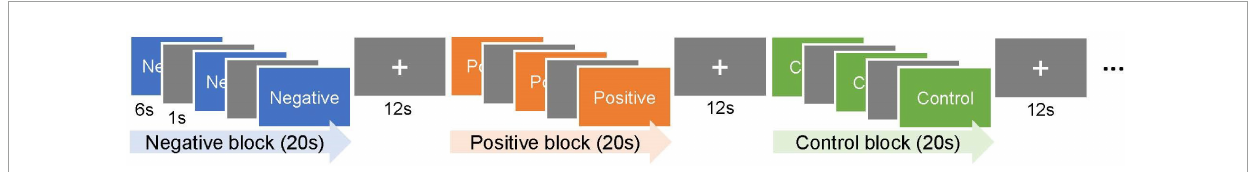
FIGURE1 Experimental design. Each block consisted of a serial presentation of three emotional pictures with the same valence, i.e., negative, positive, or neutral (control), from the International Affective Picture System. The triad of three blocks with different valences, with the order counterbalanced across participants, was repeated six times. The participants pressed the button after they had sufficiently appreciated each picture to ensure their wakefulness.